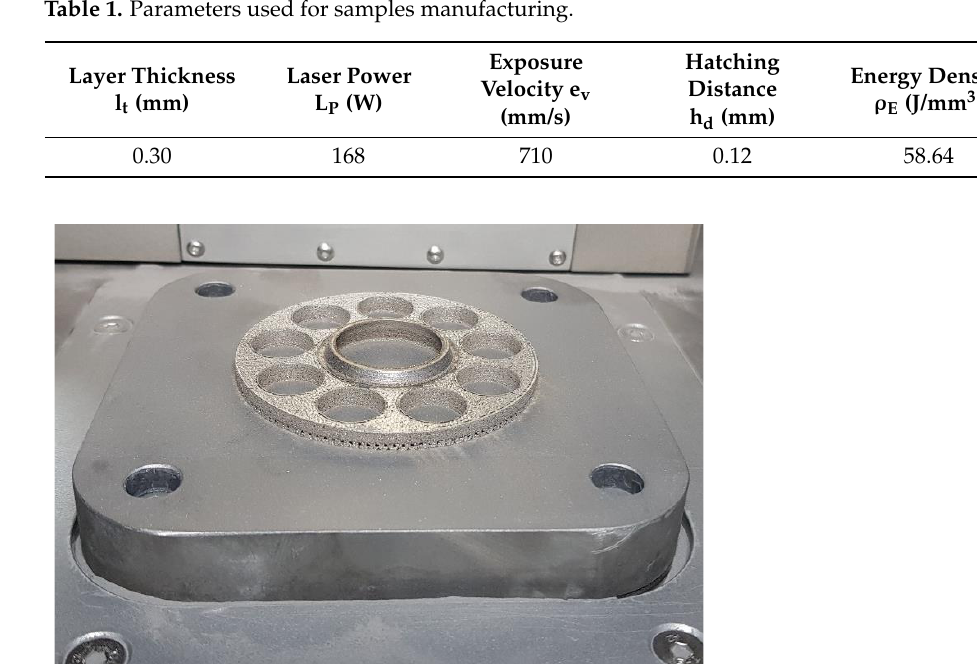
Figure 4. Chemical composition of analyzed slipper-retainer obtained in SEM-EDS analysis. Additionally, to improve the accuracy of material type detection, Rockwell hardness distribution measurements were made. Measurement points have been distributed ran- domly on the flat surface of the original slipper-retainer. Obtained results are shown in Table 2. Table 2. Hardness measurements of the slipper-retainer. Measurement 1 Measurement 2